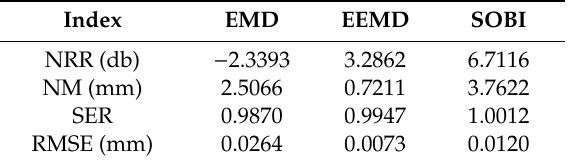
Table 2. Comparison of the four evaluation indexes among the three de-noised